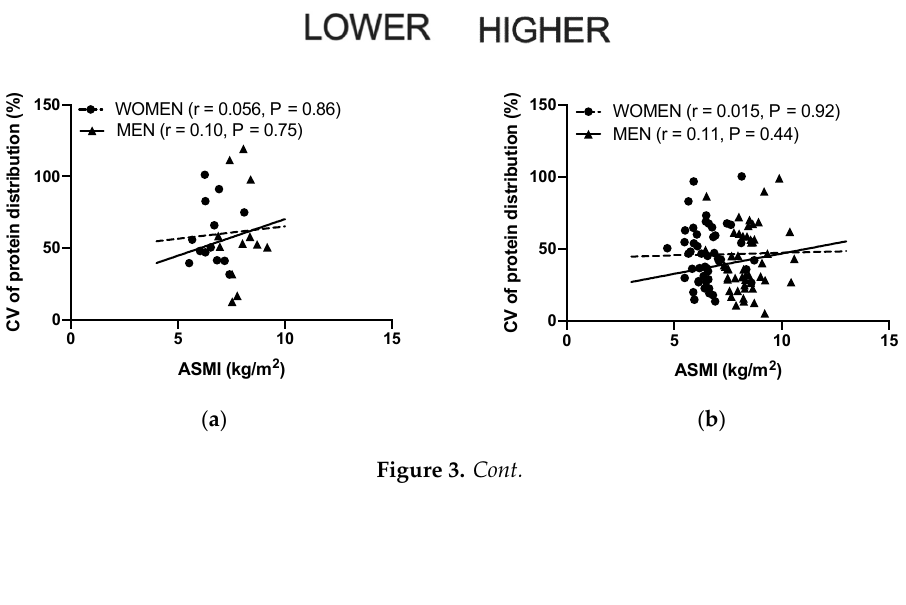
0.44)WOMEN (r = 0.015, P = 0.92)